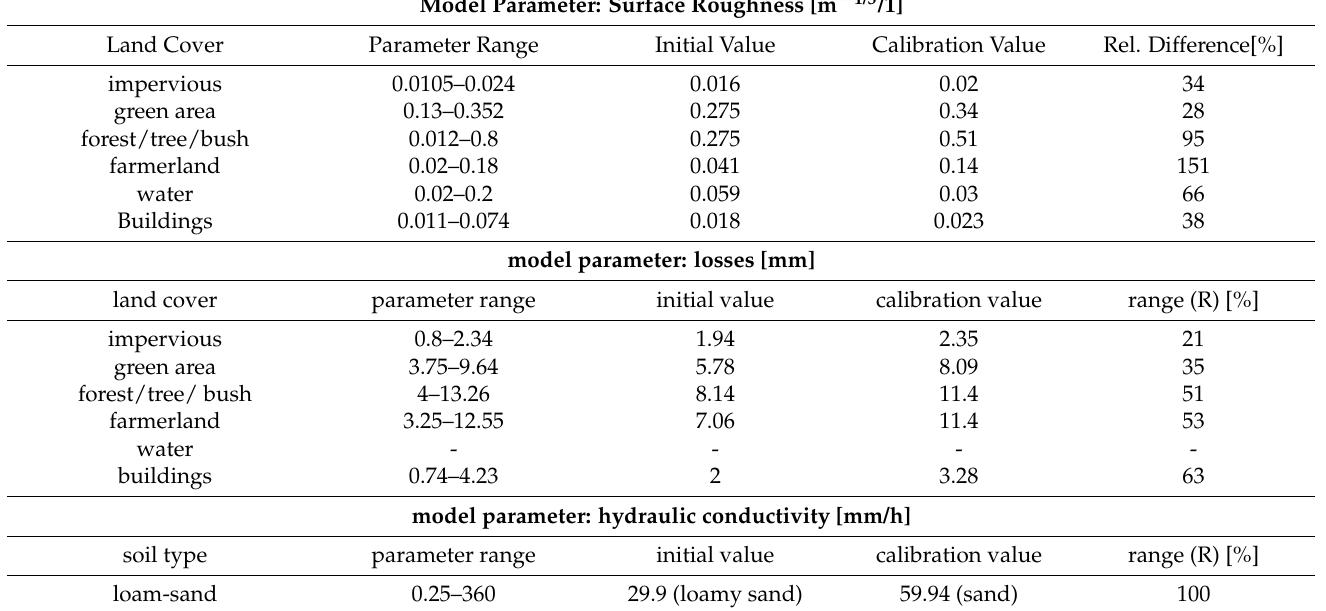
Table 1. Calibration of the sensitive model parameter surface roughness, hydrological losses (depres- sion storage and interception), and the hydraulic